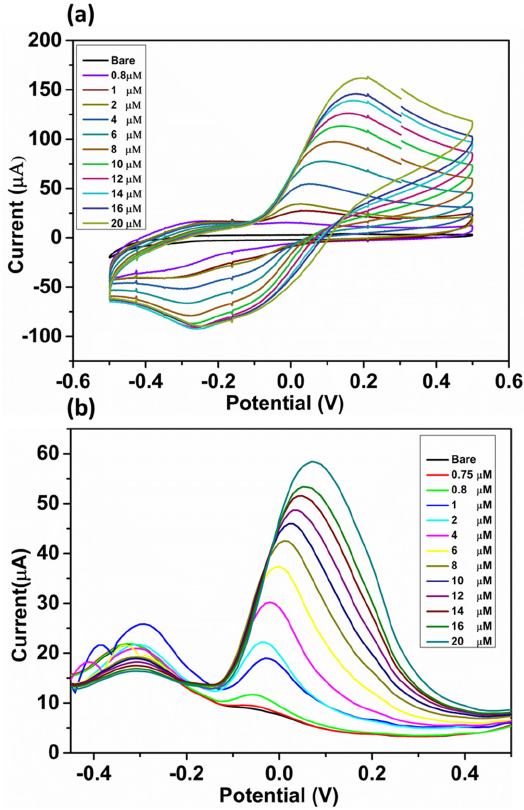
Figure 5. ( a ) CV plot for the interference study of AA and DA (1–20 μ M), ( b ) DPV plot for the interference study of DA and AA (1–20 μ M). The response to various interferents such as analog (AA), amino acid (Cyst, Argrn), cationic, and anionic (Mg 2+ , Na + , nitrate, chloride) salts were evaluated in FBS containing 6 μ M DA (Figure S17). The DPV investigation confirmed the insensitive nature of the I 2 ‐ CMP ‐ CNT ‐ 4 ‐ modified GCE towards AA, L ‐ cystine (Cyst), arginine (Argrn), Mg 2+ , Na + , nitrate, and chloride, which is in accordance with previous results. Likewise, stability and